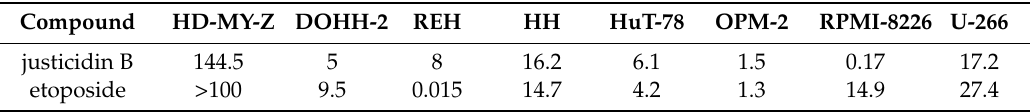
Table 7. Cytotoxiccity of justicidin B and etoposide (positive control) on lymphoma derived cell lines after 72 h